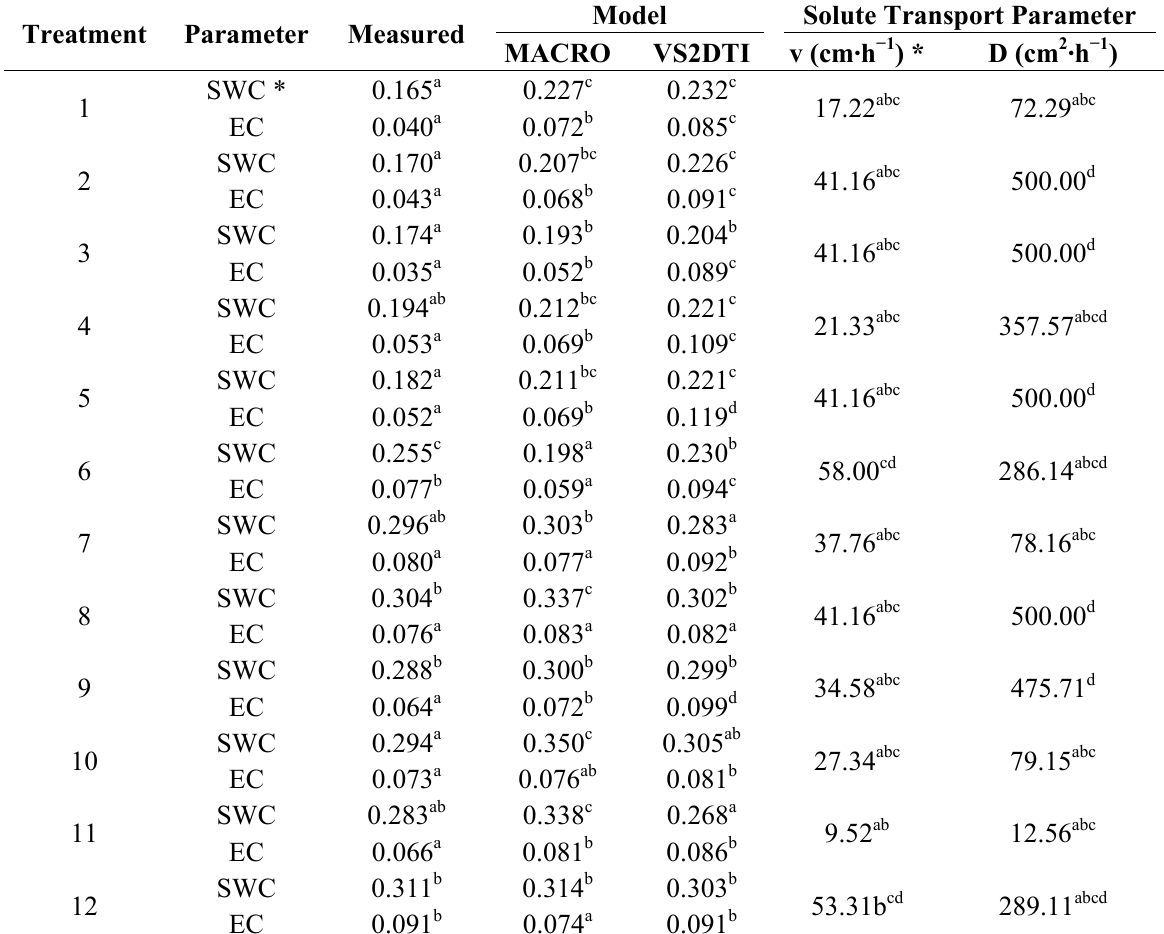
Table 5. Comparison of the means of the measured and simulated SWC and EC, and the solute transport parameters of the treatments using Tukey